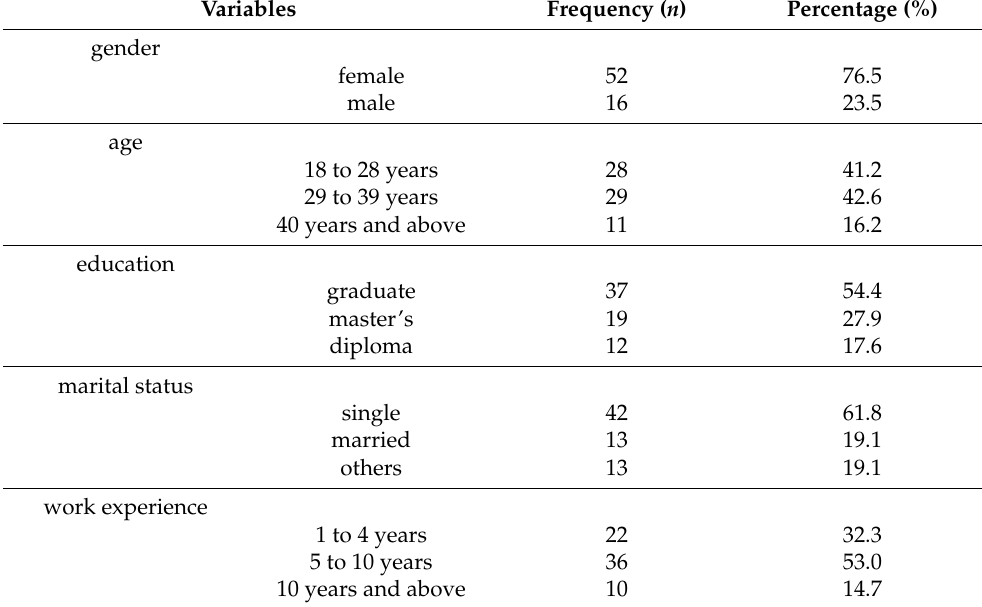
Table 1. Participants demographic characteristics.